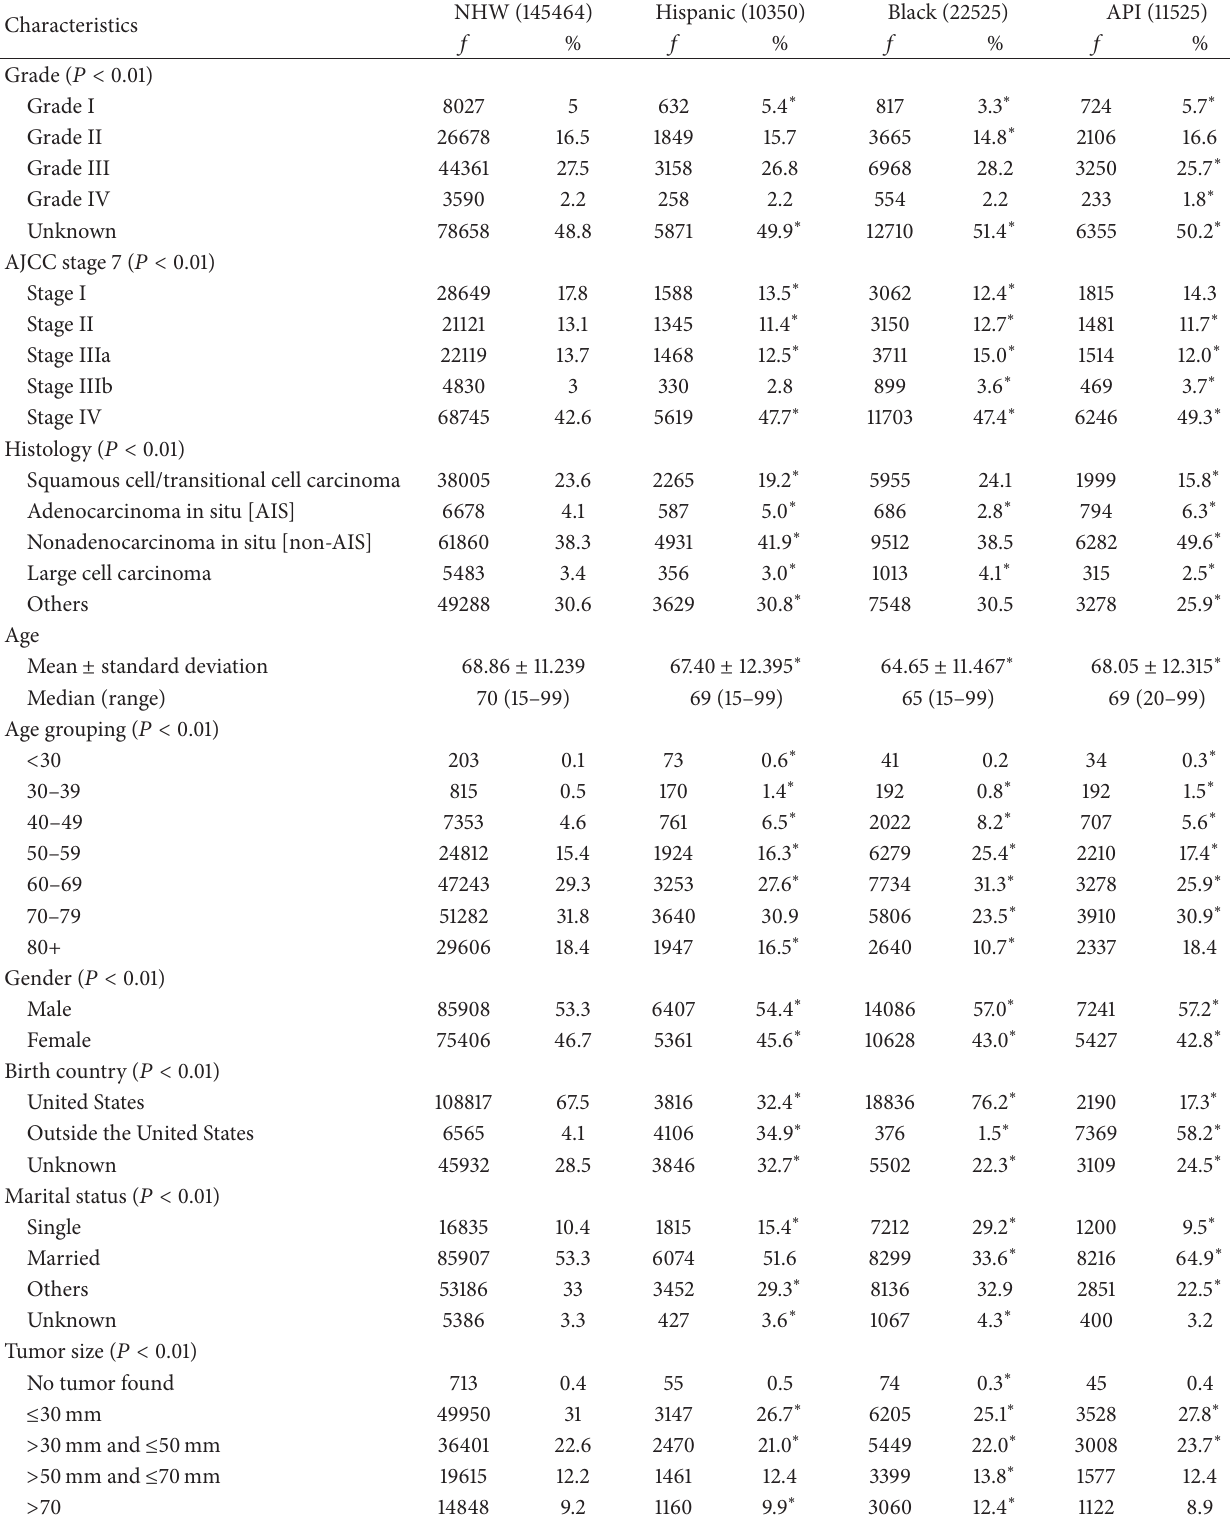
Table 1: Baseline demographic and clinicopathologic of the study